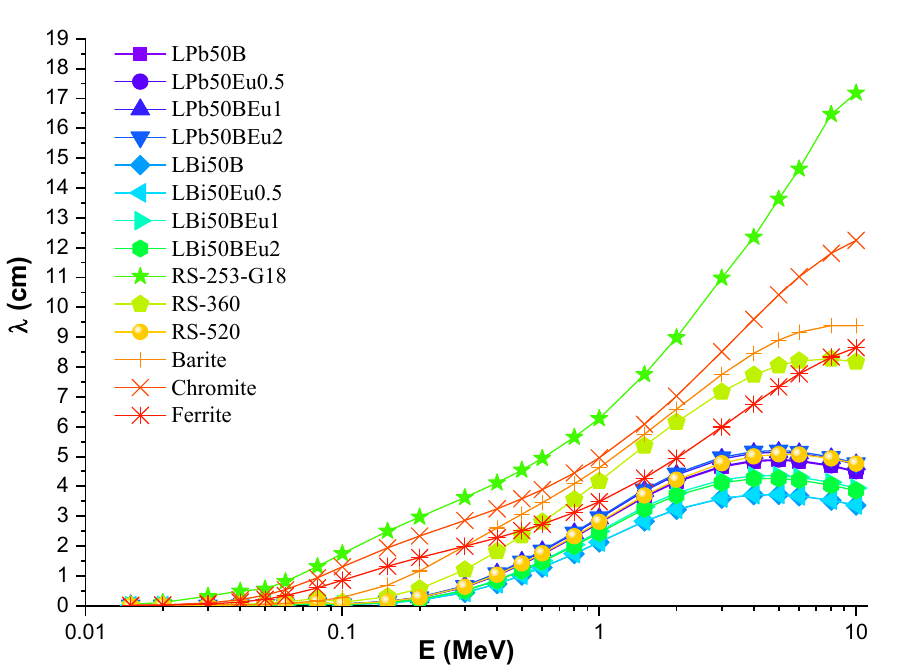
Figure 5. Variation of mean free path ( λ ) against photon energy for LPb50BEu and LBi50BEu glasses, and some commercial shielding materials.